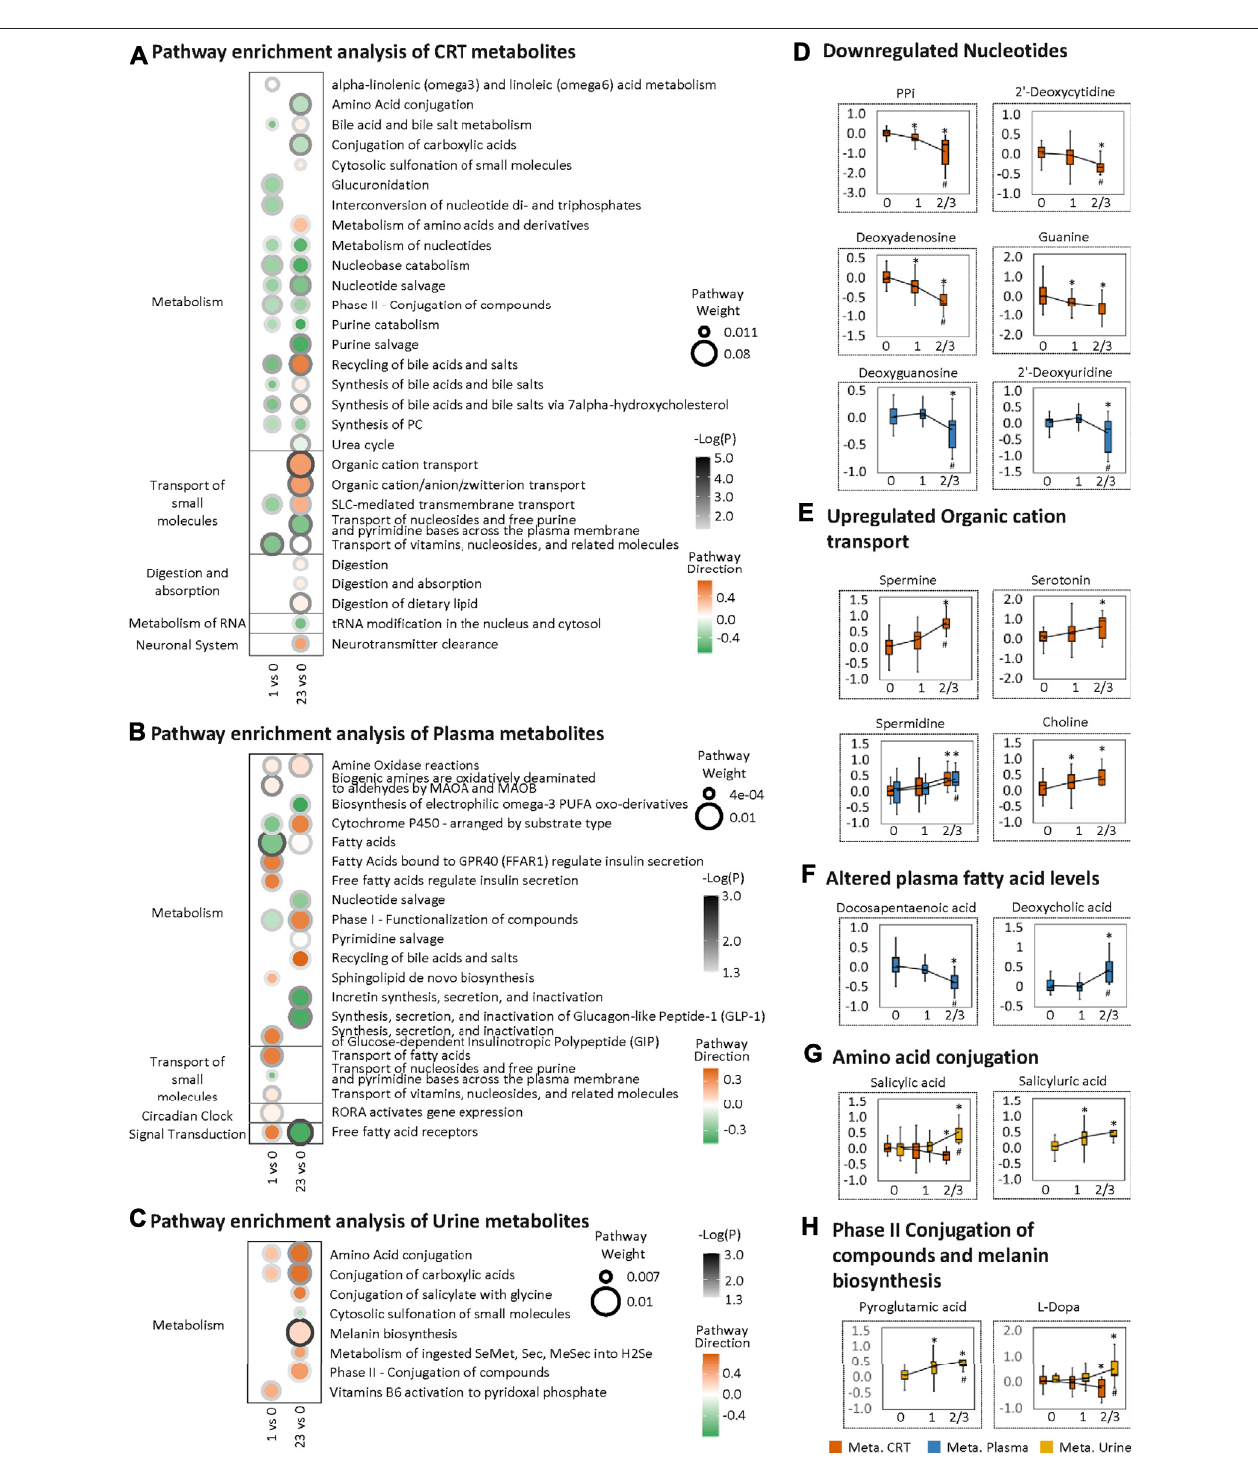
FIGURE 3 | Metabolome changes related to HFS susceptibility. Pathway enrichment analysis of differentially expressed features (DEFs) in CRT metabolome (A) , plasmametabolome (B) ,andurinemetabolome (C) .Cutoff:theminimumnumberofDEFsenrichedinthepathwaywassetas4 (A) ,2 (B) ,and2 (C) ,andthe p -valuewas set as 0.05. The dot border color represents the – log10( p ) of pathway signi fi cance. Pathway weight is de fi ned as: (Enrichment ratio) × (sum of absolute value of DEF MOFA L1weight inthepathway), andthedotsizerepresents pathway weight.Pathwaydirectionisthemedianlog10foldchange(FC)ofDEFsinthepathway(red, upregulated;green,downregulated).Boxplotsin (D) , (E) , (F) , (G) ,and (H) showtherelativemetabolitelevelsoftherelatedfeaturesenrichedinthesigni fi cantlyimportant pathwaysingroups HFS0,HFS1,and HFS2/3 (fromlefttoright).Statisticalsigni fi cance wasset as:* p < 0.05forHFS1vs HFS0,HFS2/3 vsHFS0; # p < 0.05forHFS2/3 vs HFS1 by differential expression analysis using limma.